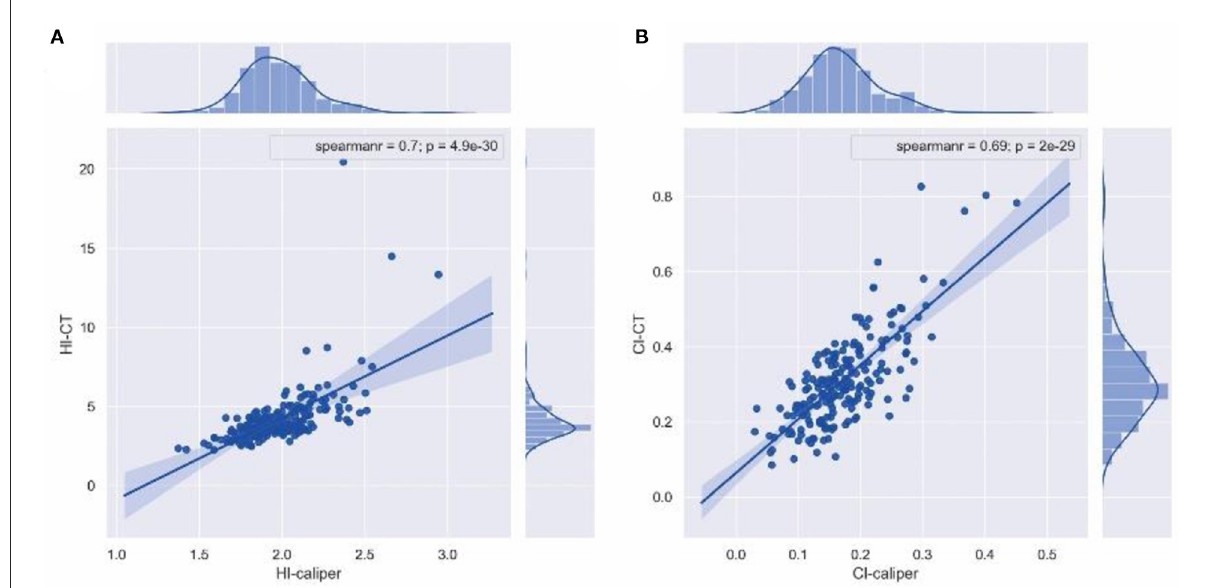
FIGURE3 Spearman’s correlation coefficient. (A) HI-caliper was strongly correlated with HI-CT (rs = 0.70, p < 0.001). (B) CI-caliper was strongly correlated with CI-CT (rs = 0.69, p < 0.001).